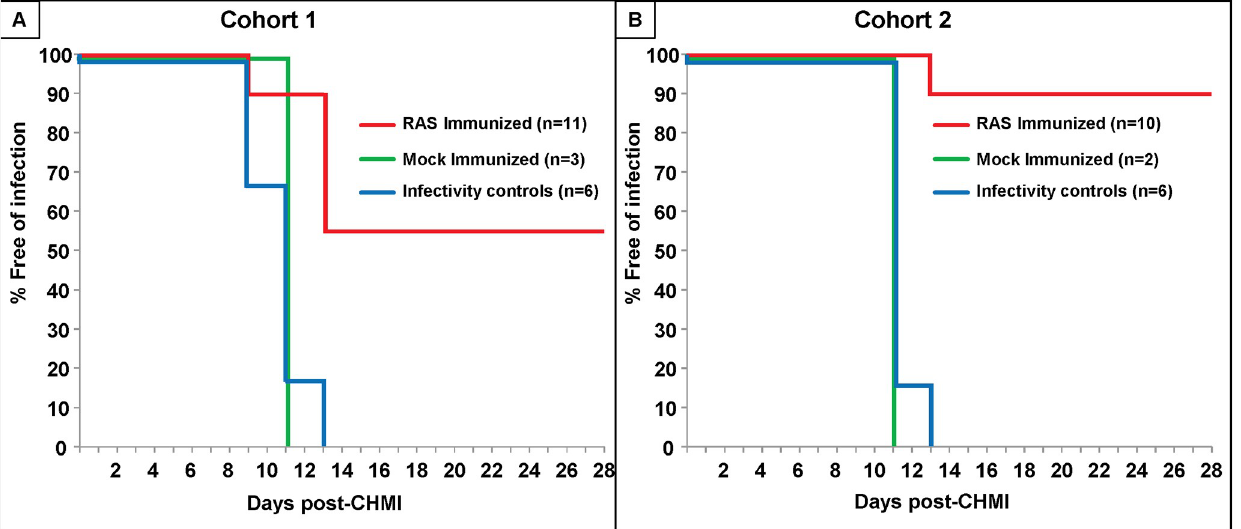
Fig 4. Development of parasitemia in the true- and mock-immunized and infectivity control subjects. Parasitemia-free survival curves (Kaplan-Meier) for true- and mock-immunized subjects and infectivity controls based on microscopic examination of peripheral blood smears. Panel A: Cohort 1 where 11 true- immunized, 3 mock-immunized and 6 infectivity controls received CHMI. Panel B: Cohort 1 where 10 true-immunized, 2 mock-immunized and 6 infectivity controls received CHMI.